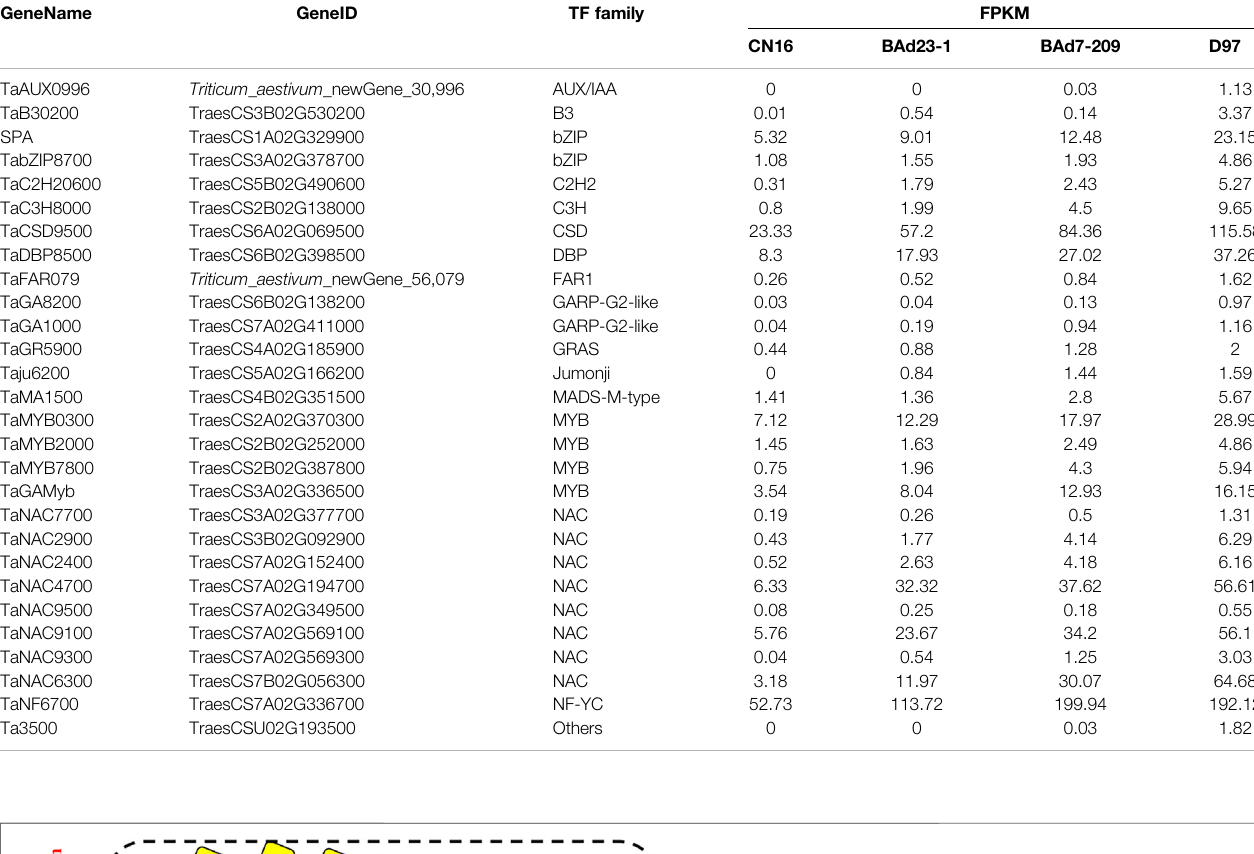
TABLE 4 | The list of TFs identi fi ed from the 459 DEGs in pro fi le 19. GeneName